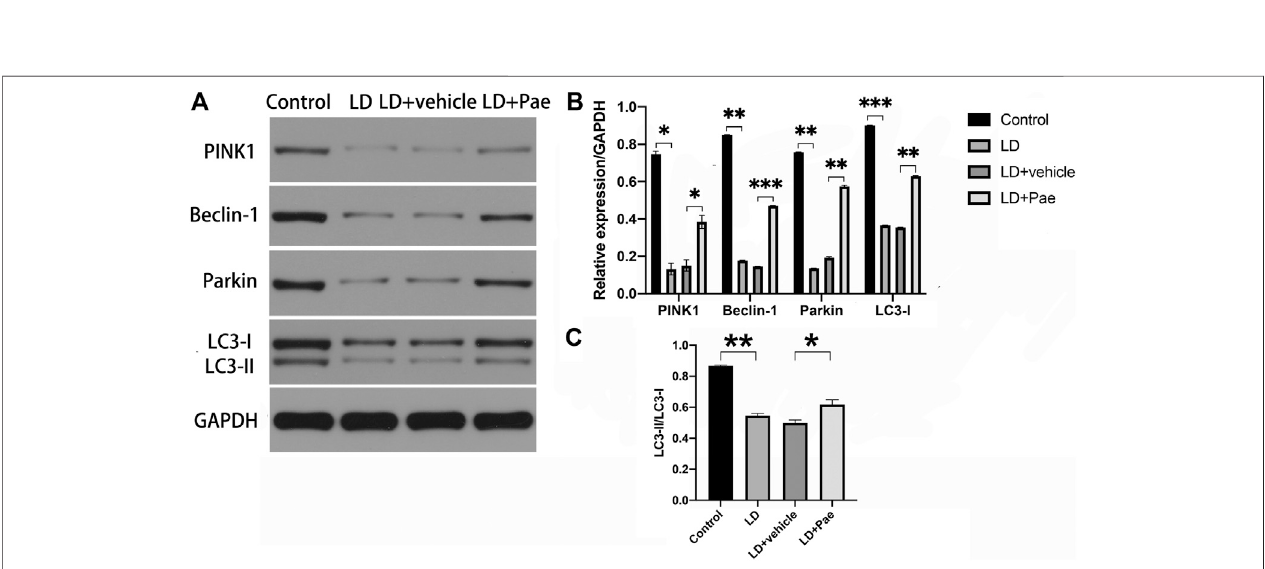
FIGURE 4 | Impacts of Pae treatment on mitophagy in light-exposed RP. Western blot analysis of LC3-I and -II and Beclin-1 proteins in light injured RP (A, B, C) showedthatintheLDandLD+vehiclegroups,theexpressionlevelsofwhichwerenotablydownregulated.Furthermore,theconversionratefromLC3-ItoLC3-IIinboth groups was signi fi cantly decreased compared with that in the NC group, suggesting the absence of LC3-II and LC3-I. Pae treatment can largely reverse the damage. WesternblotanalysisofPINK1andparkininlightinjuredRP (A,B) showedtheywereremarkablydownregulatedintheLDandLD+vehiclegroupscompared with the NC group, which can be signi fi cantly mitigated by Pae. The ratio of LC3-II to LC3-I was performing (C) . Data show mean ± SD. ( n (cid:1) 6 – 9 for each group) * p < 0.05, ** p < 0.01, *** p < 0.001.